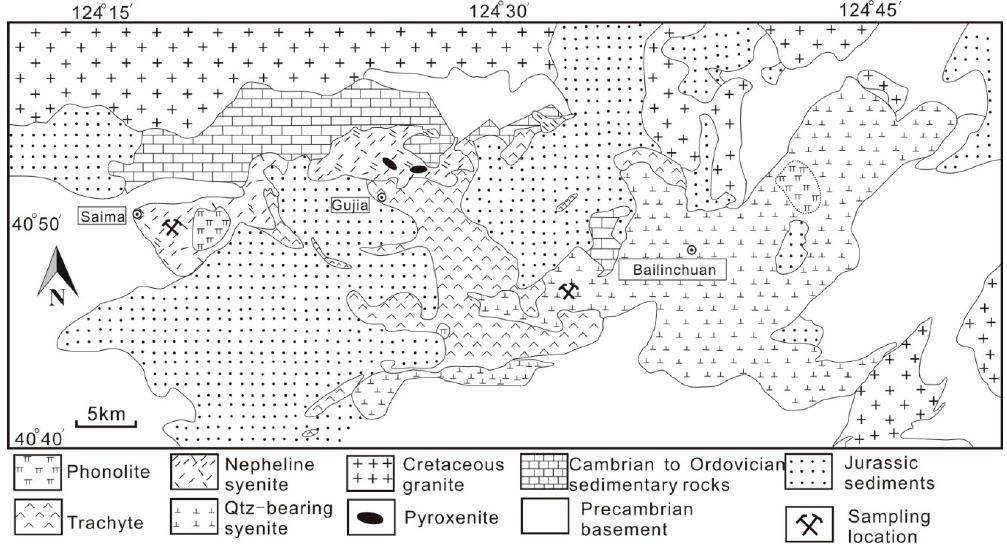
Figure 2. Geological map of the Bailinchuan alkaline complex (Modified after [9]).